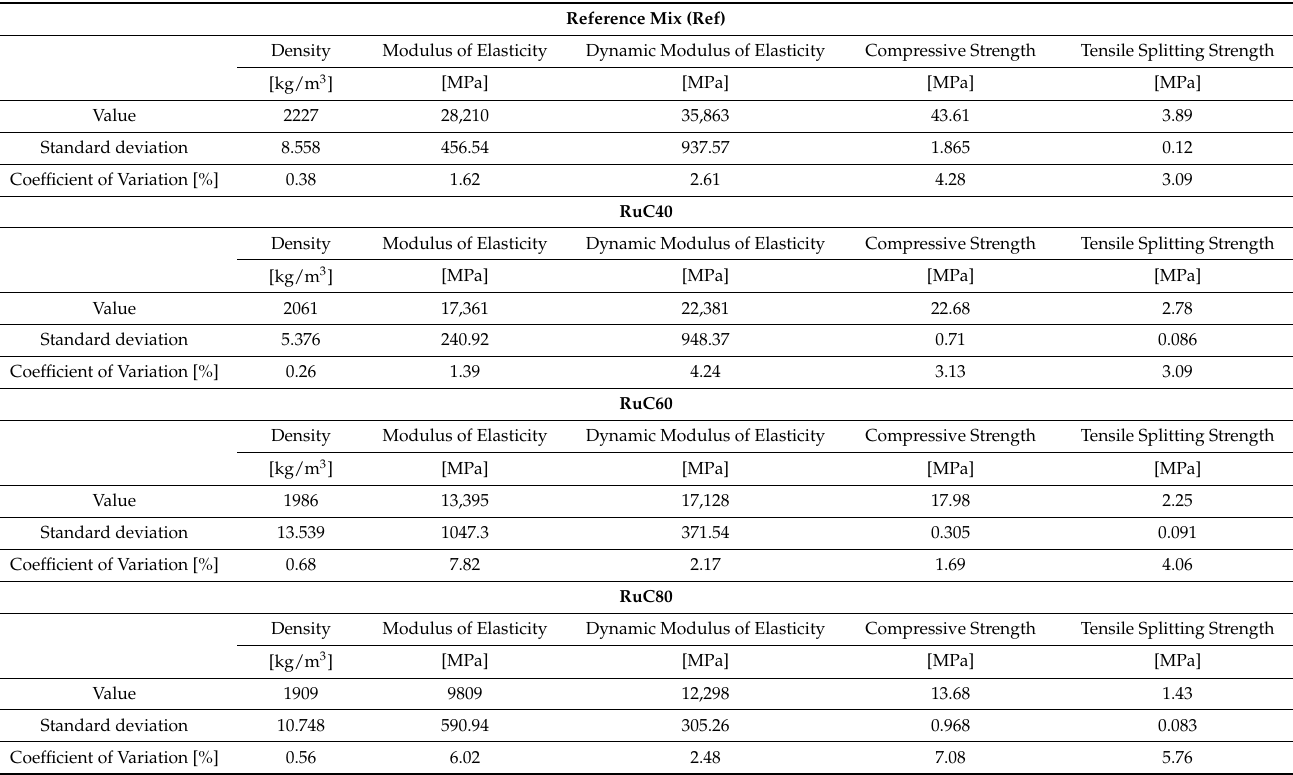
Table 6. Characterization of the experimentally obtained data at the age of 5 years. Reference Mix